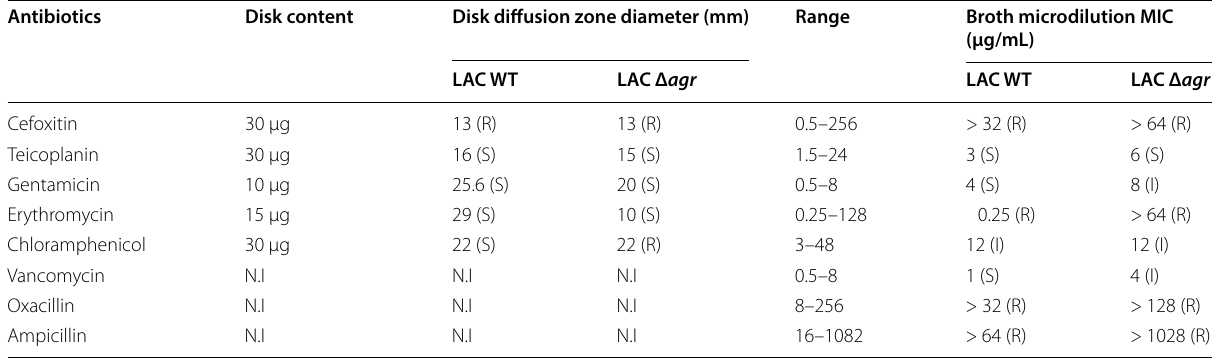
Table 1 Antibiotic susceptibility test for LAC WT and LAC Δ agr strains